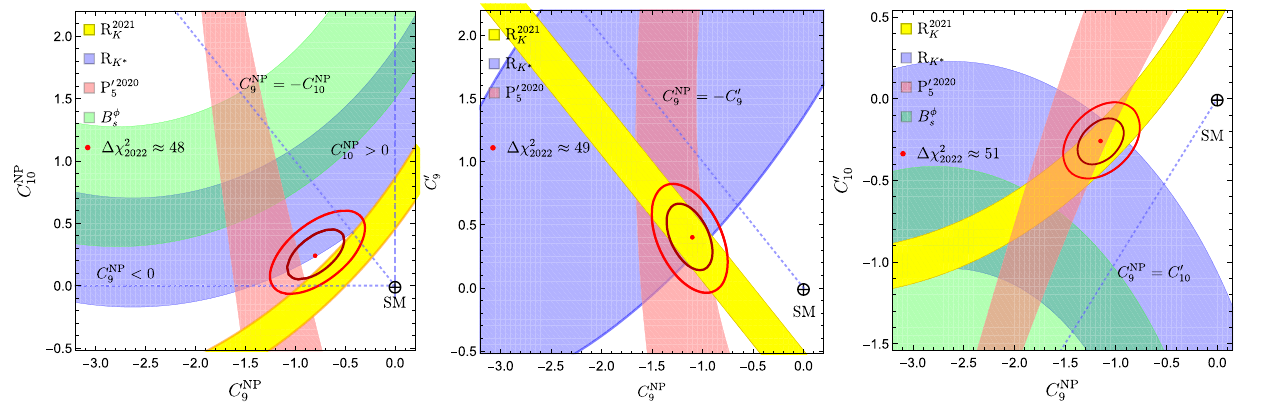
, C NP ) , ( C NP , C (cid:4) ) and ( C NP , C (cid:4) ) 9 10 9 9 9 10 = − C NP 9 10